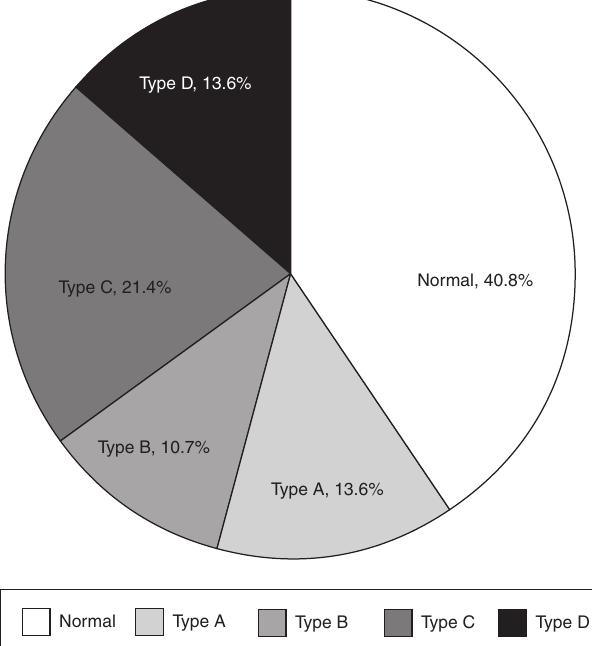
Distribution of PTA findings of the patients. Schuknecht’s typology only for patients with ARHL.